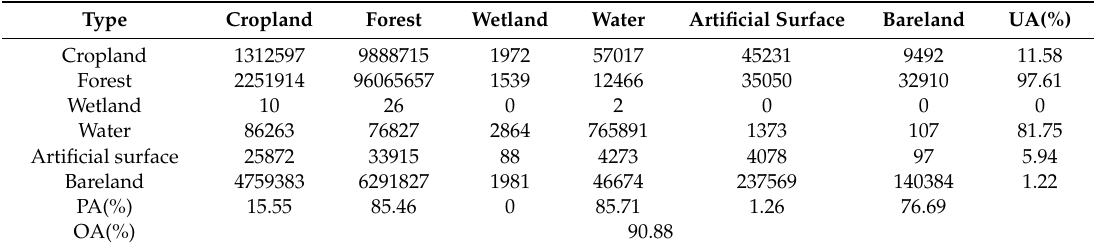
Table 6. Confusion matrix of SERVIR MEKONG2010 and FROM-GLC2010 (SERVIR MEKONG2010 is reference data, FROM-GLC2010 is data to be evaluated).